Question: Draft a figure caption describing what is shown.
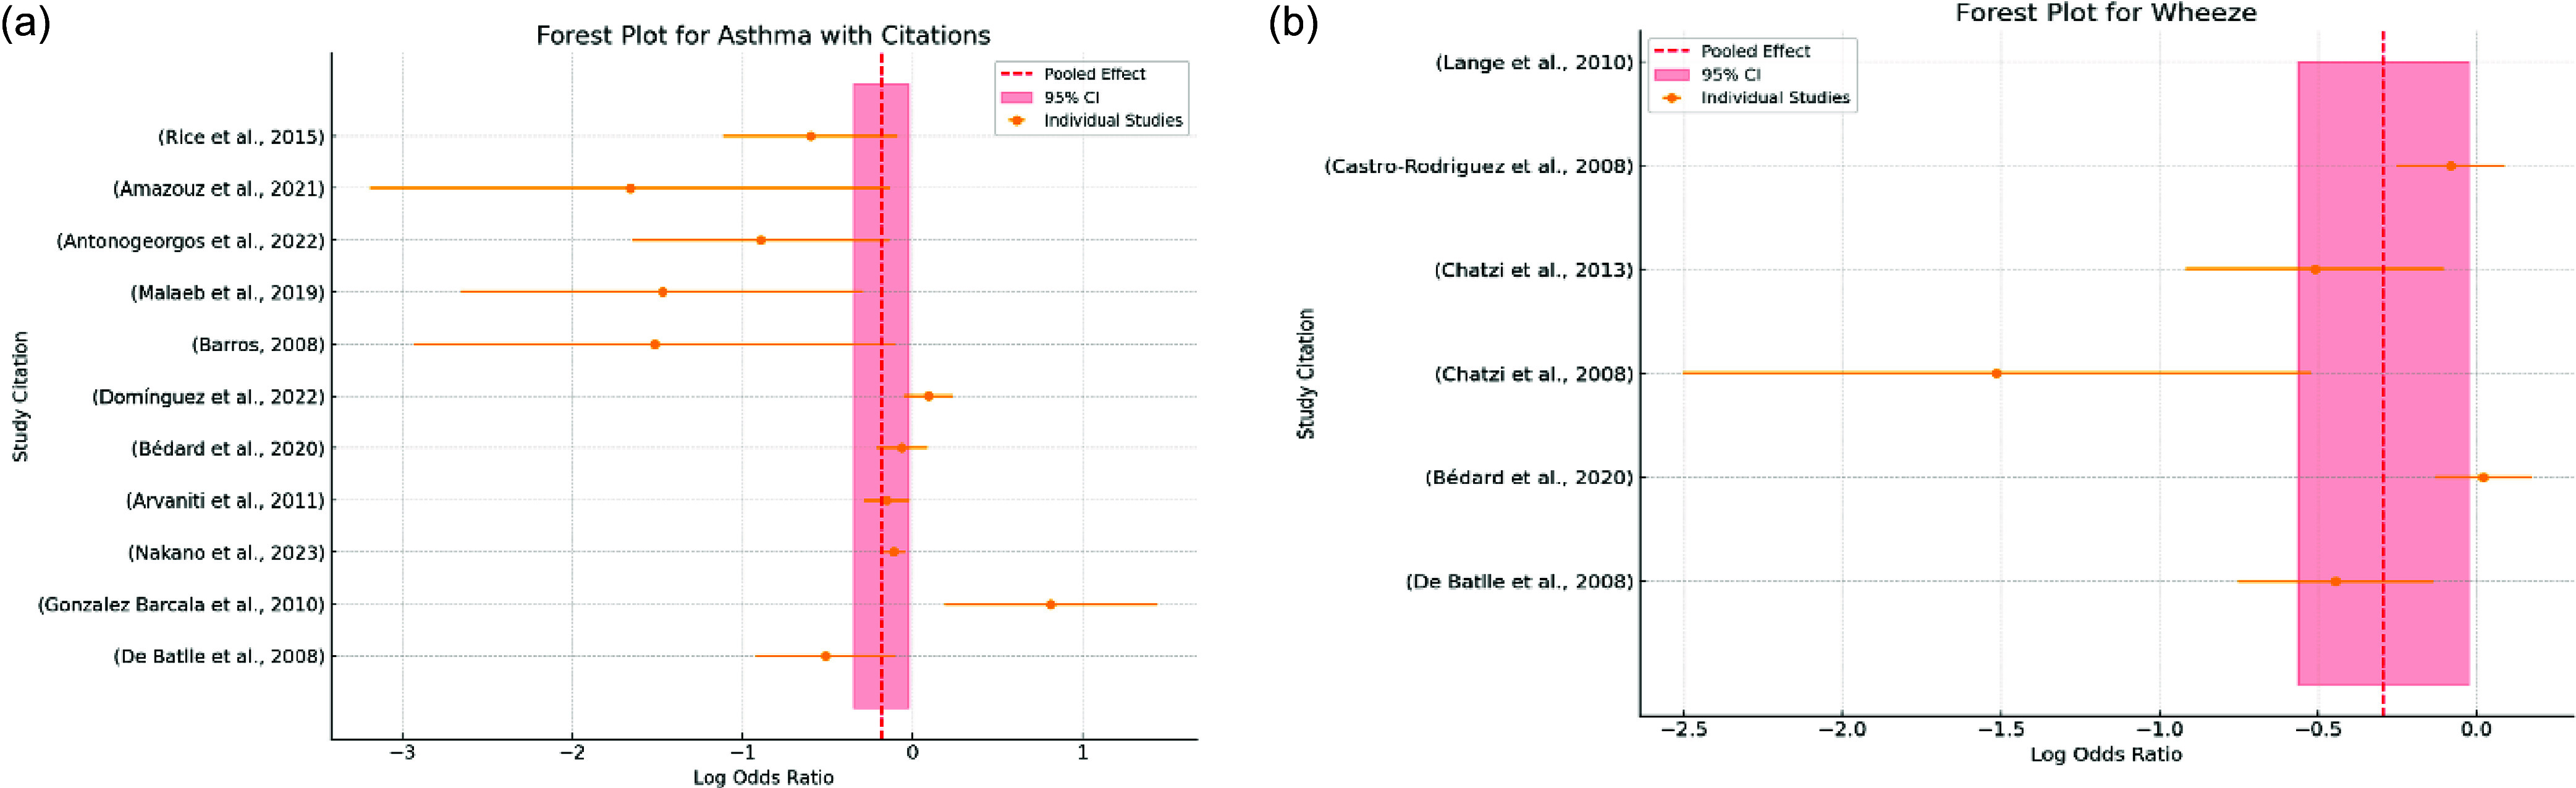
Answer: Forest plots showing the effects of the MD on (a) asthma and (b) wheeze.